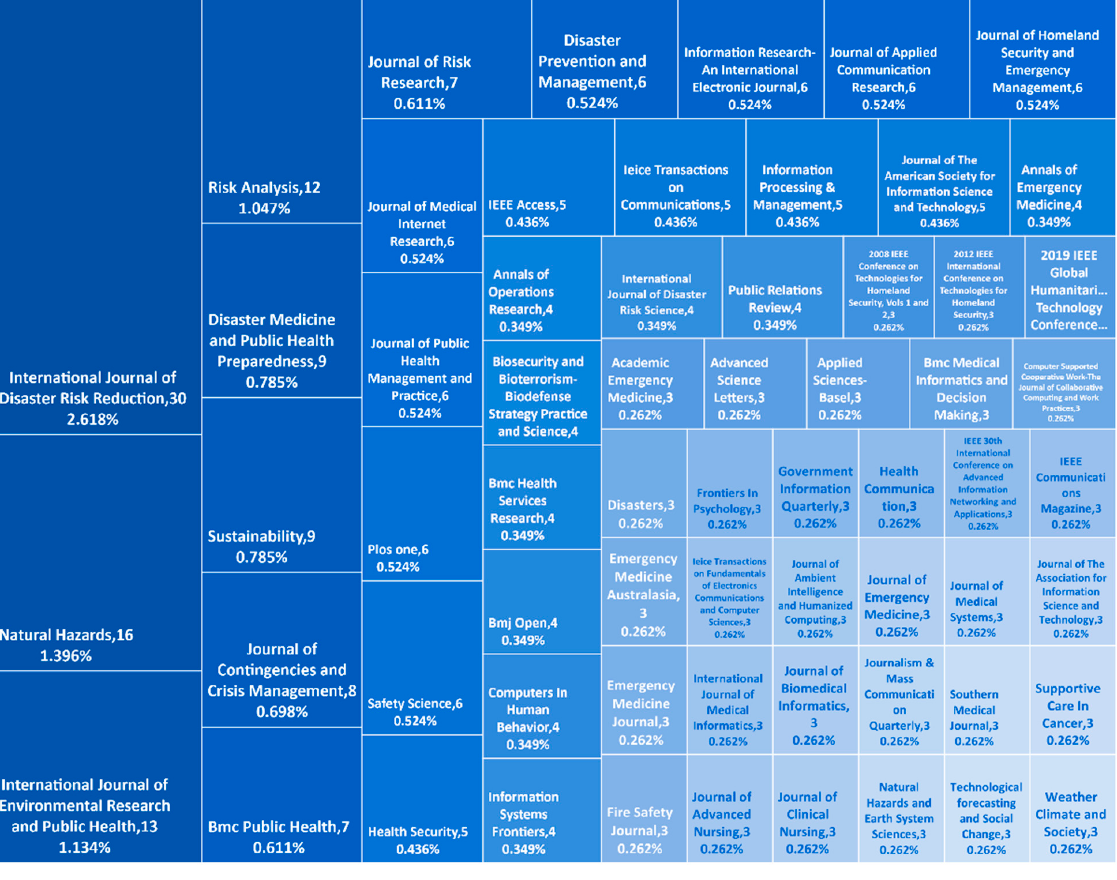
Figure 4. Treemap view of publication distribution. The number of publications of journals and their proportion in the total number of publications are shown. proportion in the total number of publications are